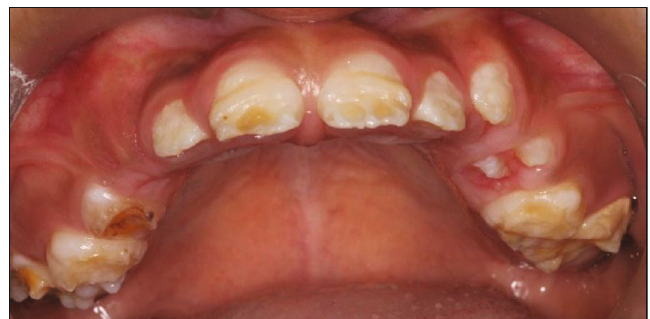
Figure 2: Upper occlusal arch.